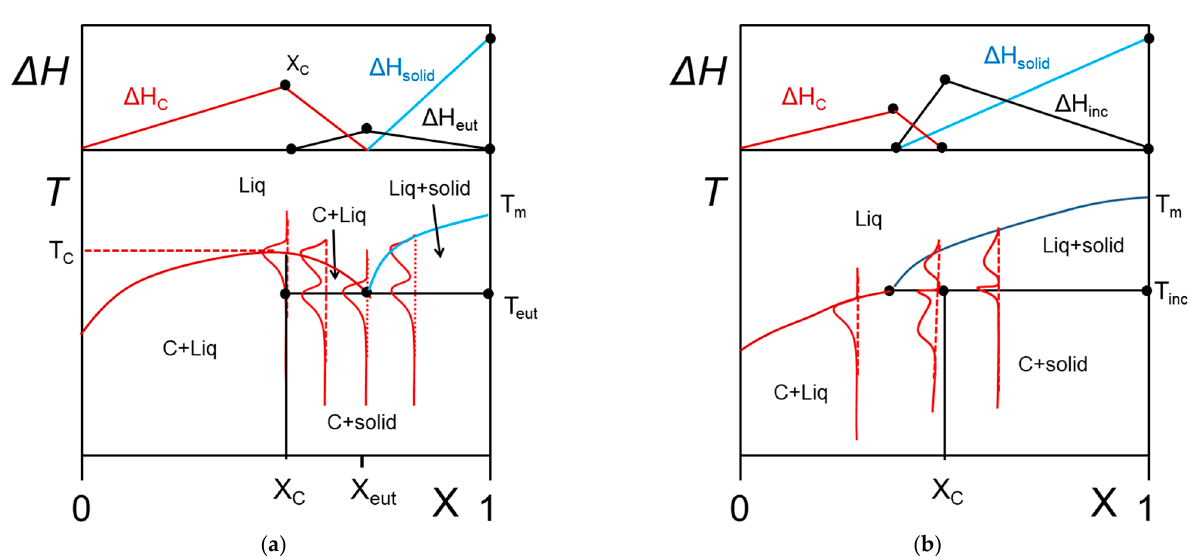
Figure 7. T-C phase diagrams. The red lines show the corresponding DSC traces. The Tamman’s diagram for the enthalpies associated with the different thermal events is shown on top. ( a ) for a molecular compound formed at X = X c . The complex further forms an eutectic compound at X = X eut . ( b ) an incongruently-melting compound where the molecular compound decomposes into a liquid phase and a solid phase at its stoichiometric composition.